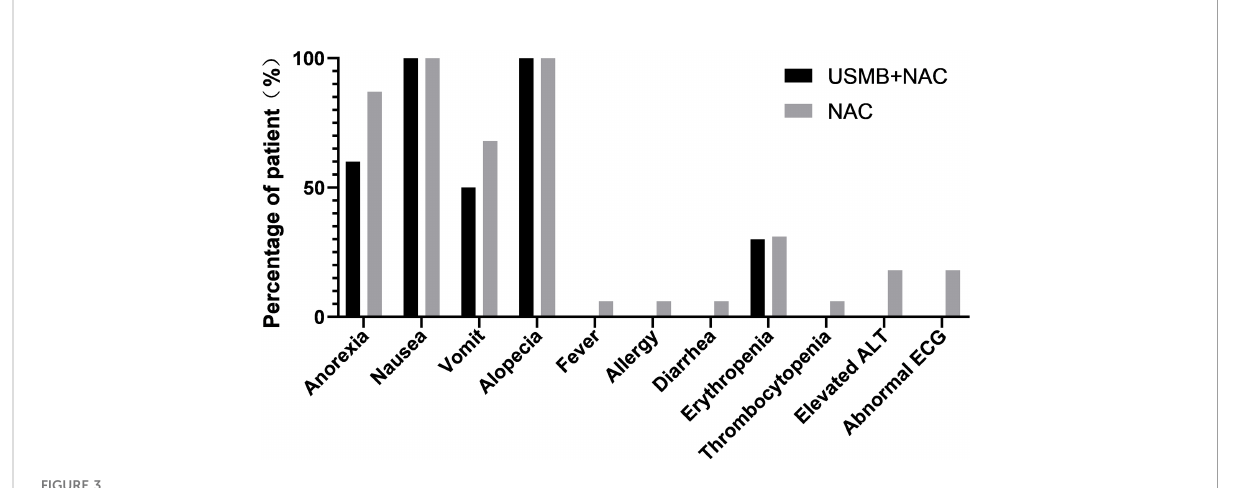
FIGURE 3 Percentage of patients experiencing adverse events.